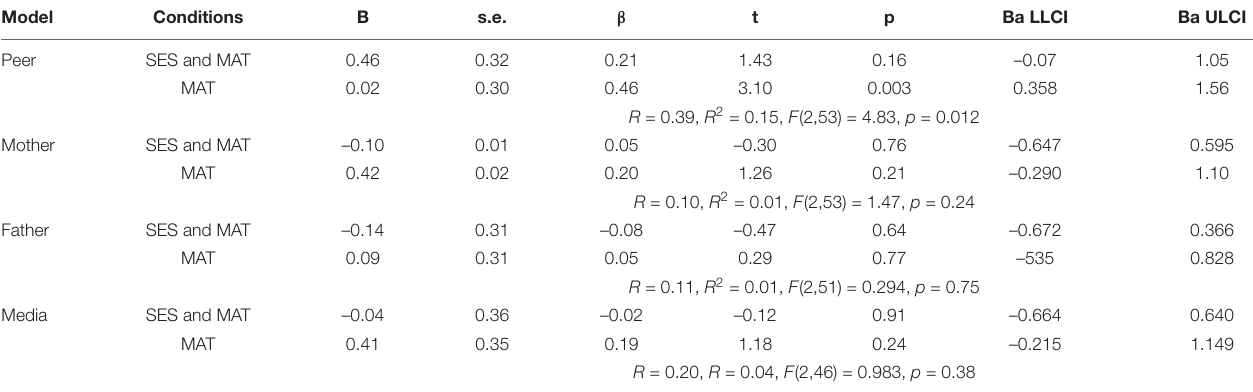
TABLE 2 | Summary of linear regression analysis predicting materialism of adolescent from activation of self-esteem and/or materialism role model (Study 2).